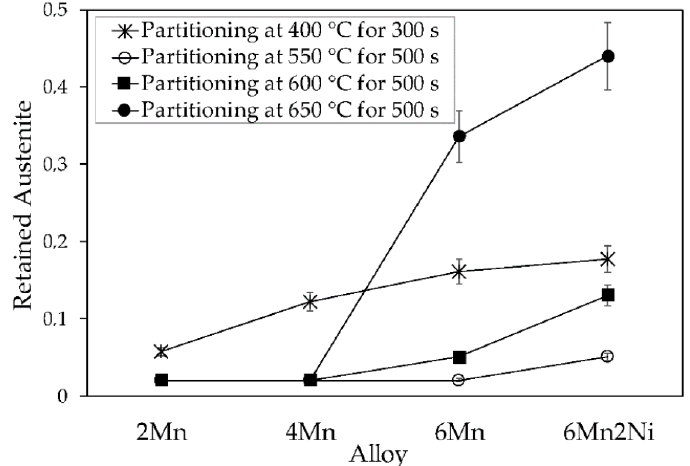
Figure 3. Retained austenite in the Q&P processed steels, partition-treated at conventional (400 °C) and high (550 °C, 600 °C, and 650 °C) partitioning temperatures.